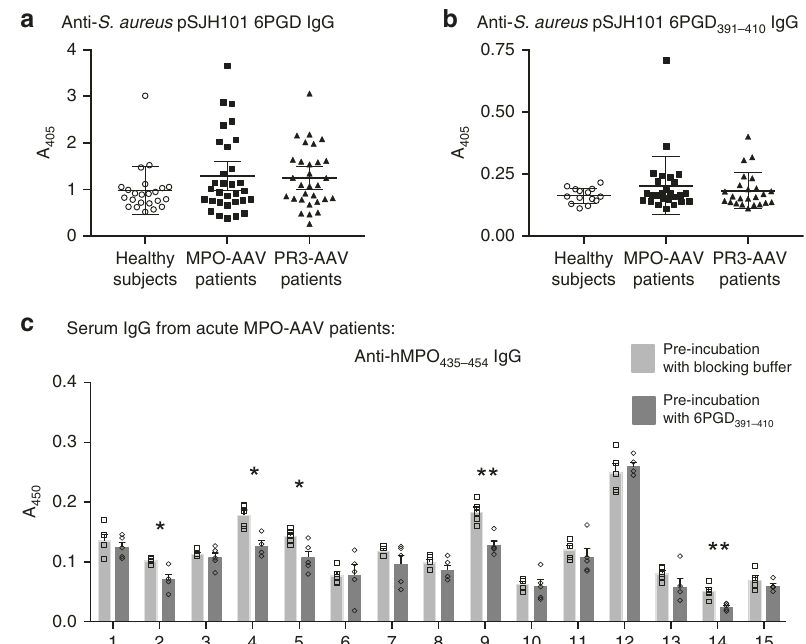
Fig. 4 Humoral responses to 6PGD and S. aureus pSJH101 6PGD 391 – 410 in humans. a Sera from healthy subjects ( n = 23), MPO-AAV ( n = 31) and PR3-AAV patients ( n = 30) assessed by ELISA for pSJH101-derived recombinant 6PGD. b Sera from healthy subjects ( n = 14), MPO-AAV ( n = 26) and PR3-AAV patients ( n = 24) assessed by ELISA to pSJH101 6PGD 391 – 410 . c S. aureus pSJH101 6PGD 391 – 410 inhibits autoantibody binding to human MPO 435 – 454 (the MPO 409 – 428 homolog) in acute MPO-AAV. Serum IgG from patients with acute MPO-AAV ( n = 15) were pre-incubated with S. aureus pSJH101 6PGD 391 – 410 then used to detect anti-hMPO 435 – 454 IgG antibodies by ELISA. Values are quintuplicates. Error bars in a and b are mean ± s.d., in panel c mean ± s.e.m. * P < 0.05, ** P < 0.01, Mann – Whitney U- test. Source data are provided as a Source Data fi